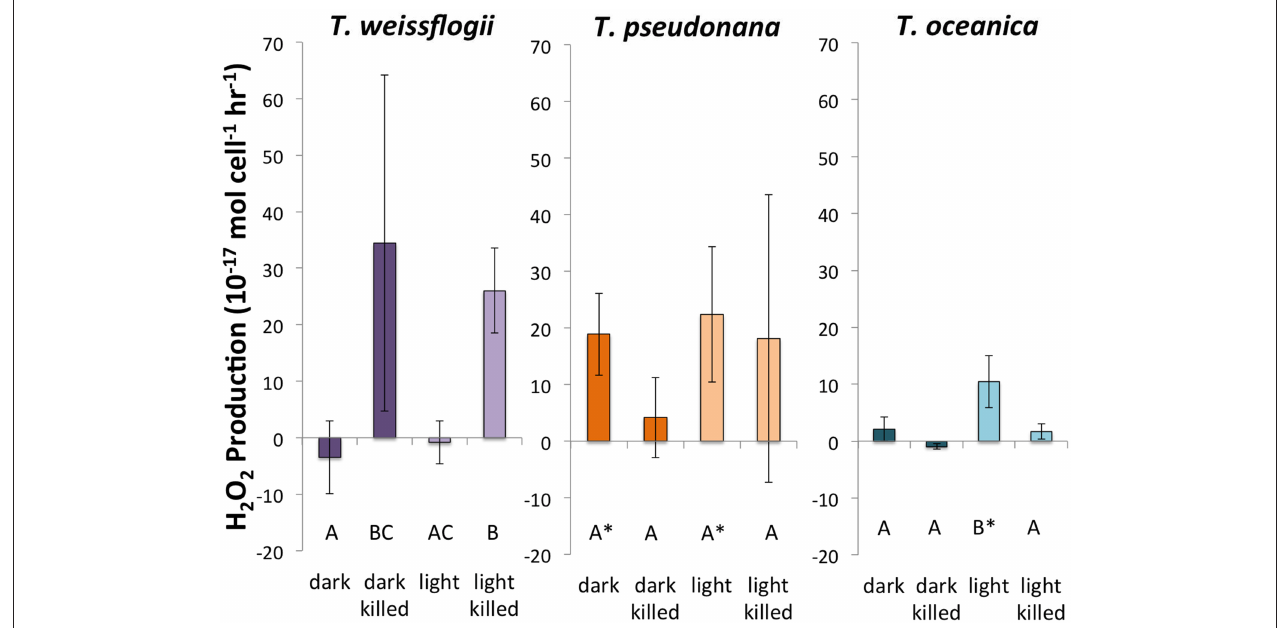
FIGURE 3 | Calculated H 2 O 2 production rates in Thalassiosira spp. Error bars represent one standard deviation. Letters designate rates significantly different from each other within each panel. Asterisks represent H 2 O 2 production rates that are significantly different from